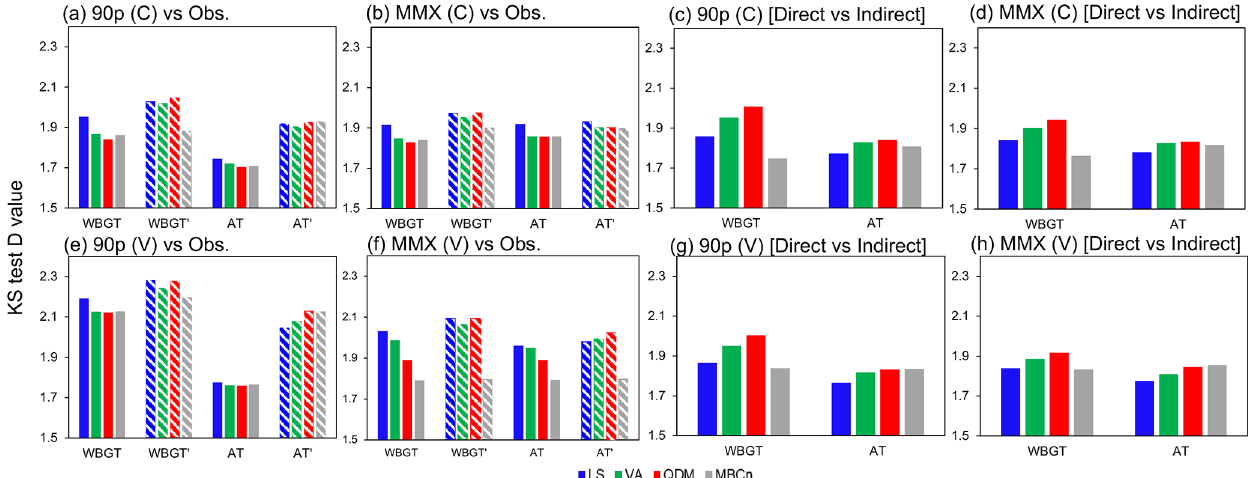
Figure 5. K–S test D value between bias-corrected output and observation for (a, e) 90p and (b, f) MMX and between direct and indirect corrected output for (c, g) 90p and (d, h) MMX. The D value is the ensemble mean of five RCMs averaged over South Korea (land only). The different colors stand for different BC methods. Panels (a) – (d) are for the calibration period (C), and (e) – (h) are for the validation period (V). In (a) , (b) , (e) , and (f) , the solid and patterned fill is for the direct and indirect BC, respectively.